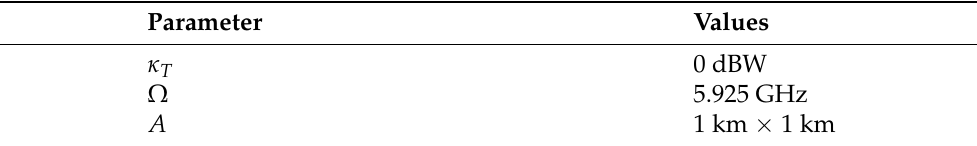
Table 1. Parameter settings for